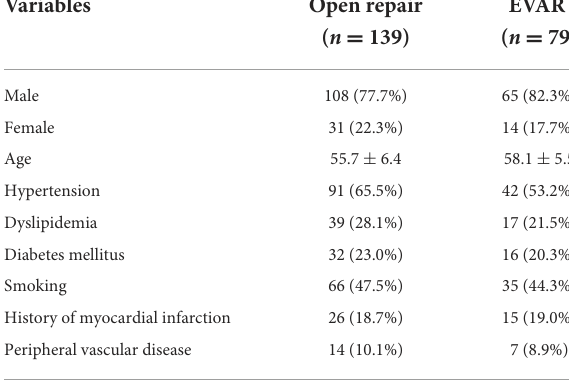
TABLE 1 Demographics and comorbidities of patients undergoing open repair or EVAR for AAA during 2004–2019. Variables